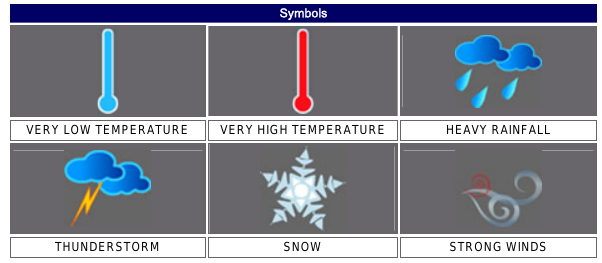
Table 2. The symbols of the weather alerts. Table 3. The symbols of the human discomfort and the fire weather